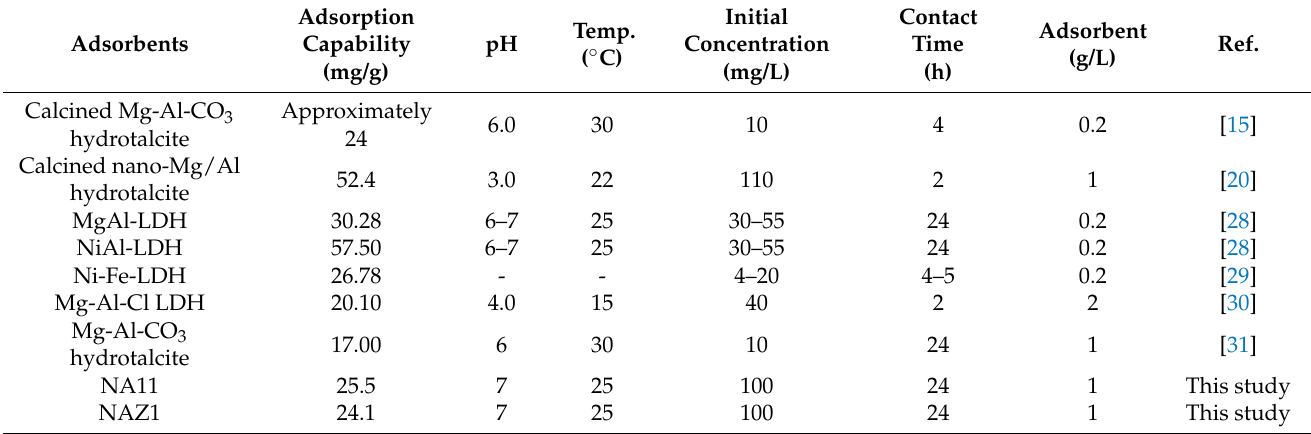
Table 1. Comparison of Cr(VI) adsorption capacity of NA11 and NAZ1 with other reported adsorbents.